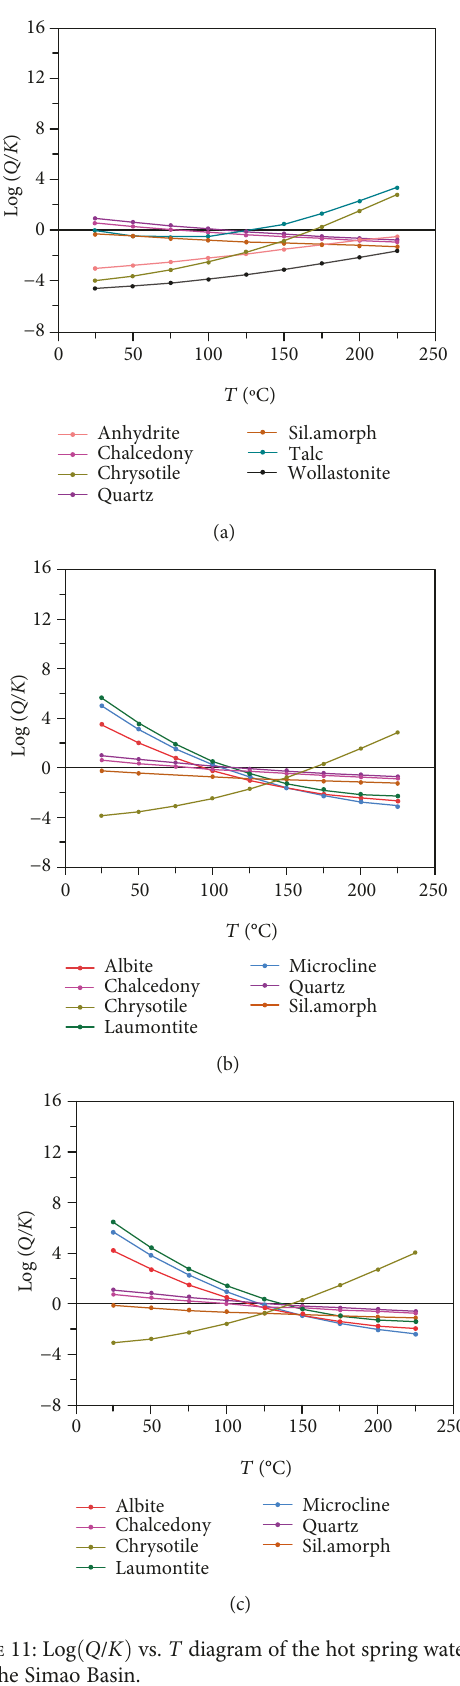
Figure 11: Log Q / K vs. T diagram of the hot spring water sample S1 in the Simao